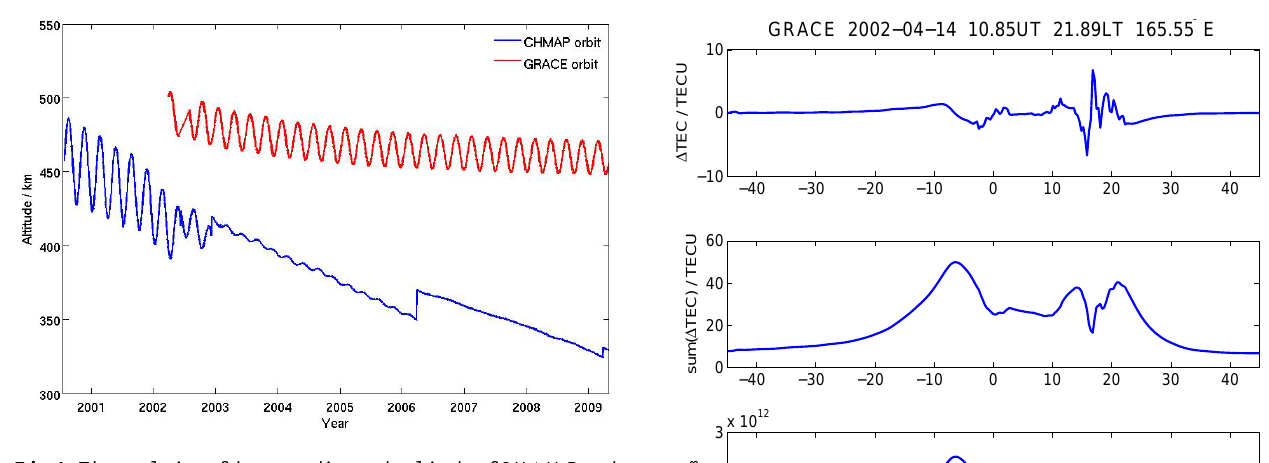
Fig. 1. The evolution of the ascending node altitude of CHAMP and GRACE from 2001–2009. The CHAMP orbit has decayed about 150km and GRACE has decayed about 25km during this time.